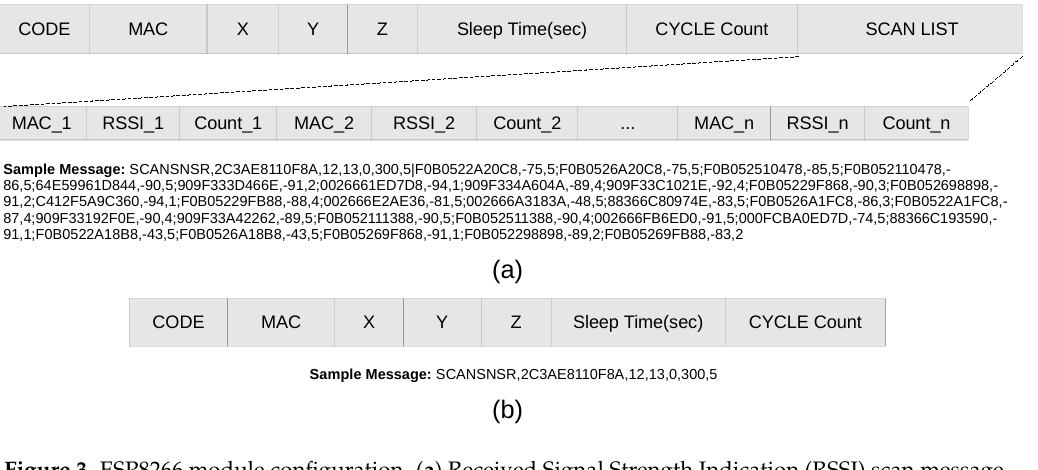
Figure 2. ESP8266 module as a Wi-Fi sensor node. ( a ) ESP8266 custom with battery, ( b ) Sensor operating cycle.